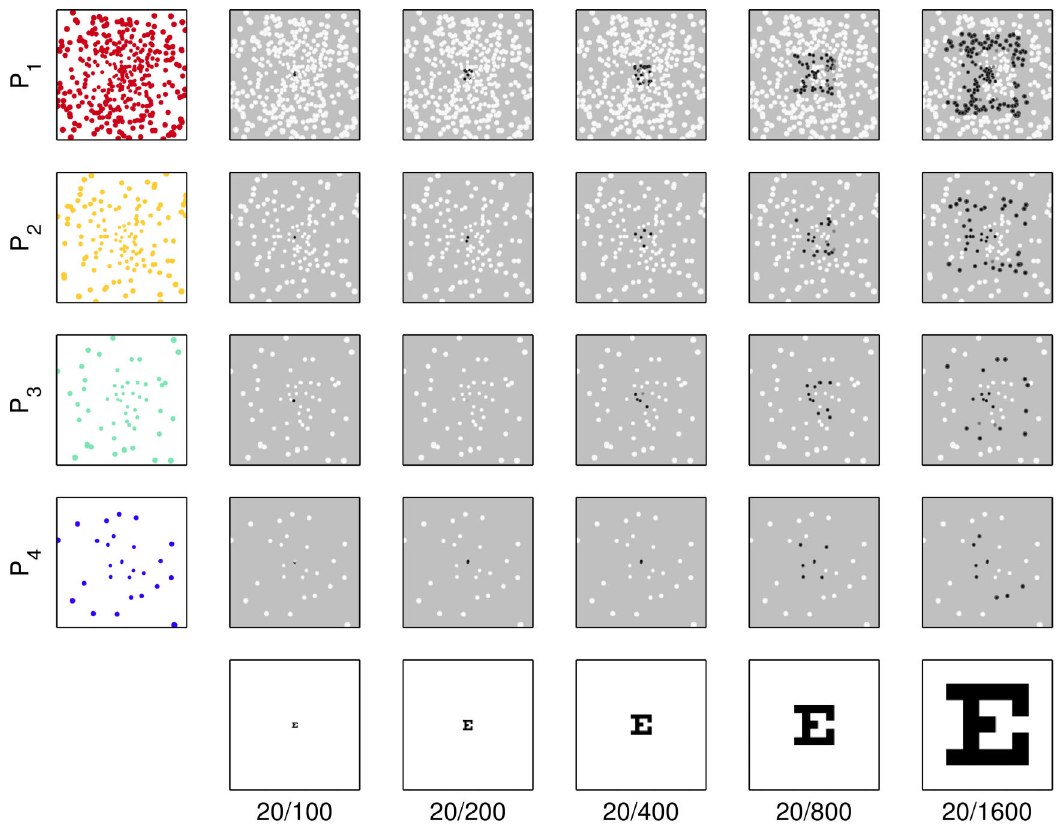
Figure 3. Stimulus combinations. The combinations of optotype size F 1 –F 5 , Snellen 20/100 through 20/1600 (horizontal direction) and phosphene pattern P 1 –P 4 (vertical direction) are shown in this collection of snapshots of the center part of the subject display during the Free View phase. Parameter values were selected such that it was impossible for subjects to identify letters with the lowest resolution phosphene pattern viewing the smallest optotypes (lower left subfigure) to provide a negative control, and quite easy with the highest resolution pattern viewing the largest optotypes (upper right subfigure) to provide a positive control. Snapshots shown are for gaze positions at the center of the monitor. Only the centralmost 10 u of stimuli are shown; the remainder of the screen would be uniformly gray. Stimuli, animated through the gaze-contingent mechanism, were more readily identifiable than the static images above might suggest.